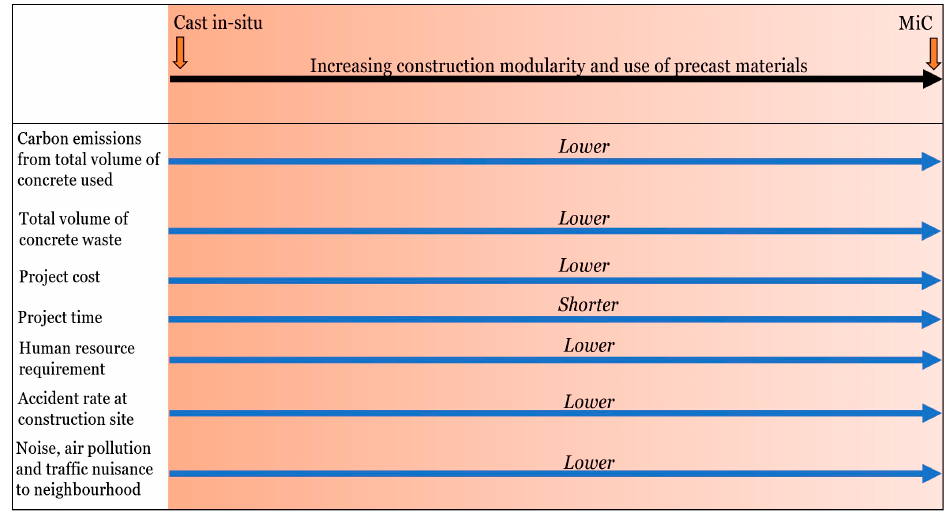
Figure 1. Comparison of Sustainability Impacts of Different Construction Methods.